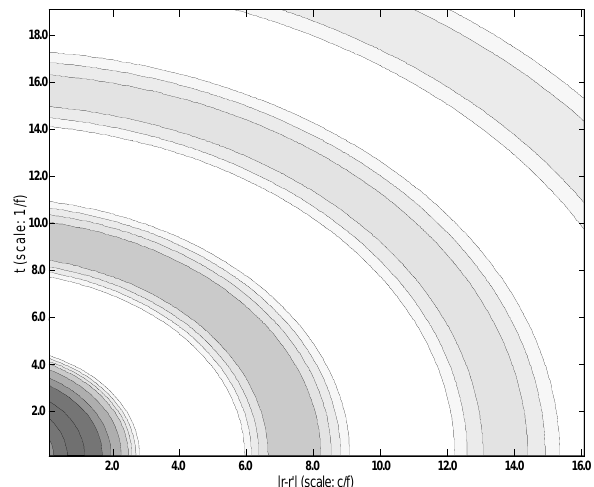
Fig. 1. Spatio-temporal structure of the Green’s function (19) (con- Figure 1 ． S patio-temporal structure of the Green’s function (3.8) (contour lines in tour lines in divergent regions are not shown). The figure shows that divergent regions are not shown). The figure shows that a pulsation at time t’ of the a pulsation at time t 0 of the forcing located at r 0 can induce convec- forcing located at ' r can induce convective structures around (shadow areas), and that tive structures around (shadow areas), and that these structures will these structures will move towards the “source” at ' r . move towards the “source” at r 0